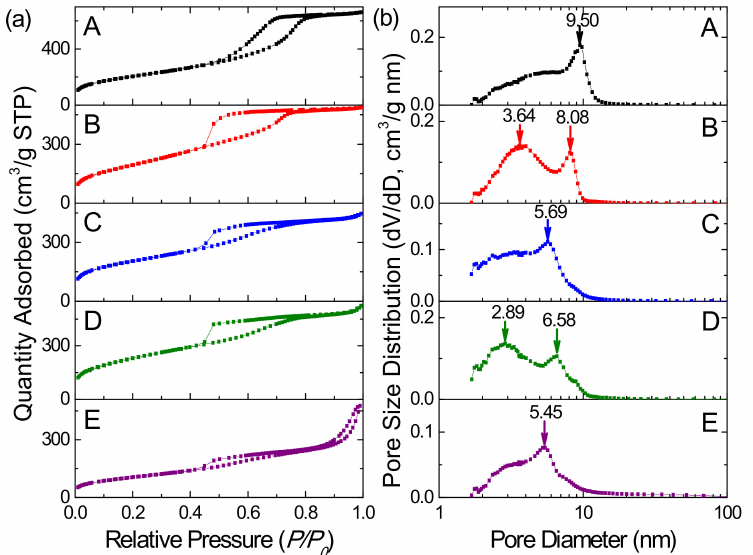
Figure 7. ( a ) Nitrogen adsorption-desorption isotherms and ( b ) pore size distribution of mesoporous silica samples: PMSA-2 (A), PMSA-4 (B), PMSB-2 (C), PMSB-3 (D), PMSB-4 (E).